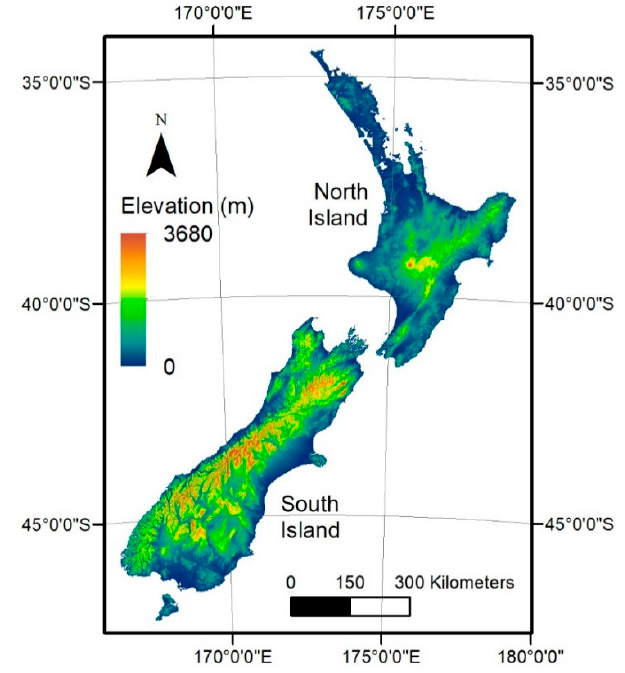
Figure 1. New Zealand location and topography (m).